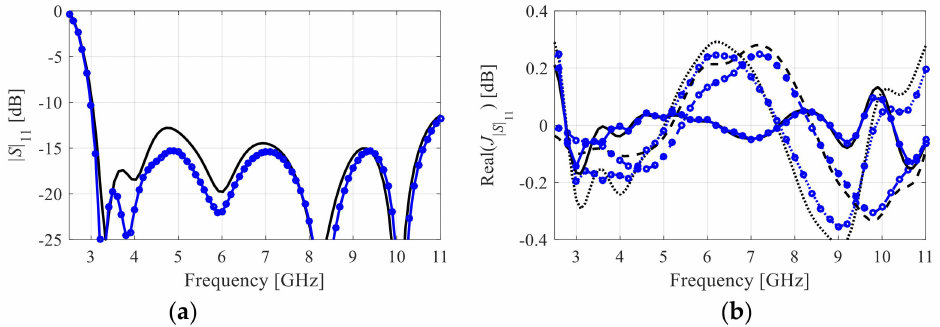
Figure 1. Exemplary reflection responses and reflection sensitivities of Antenna I of Section 3: ( a ) high-fidelity electromagnetic (EM) model reflection response (-o-o) and low-fidelity EM model response (—), ( b ) sensitivity with respect to selected antenna geometry parameters: high-fidelity EM